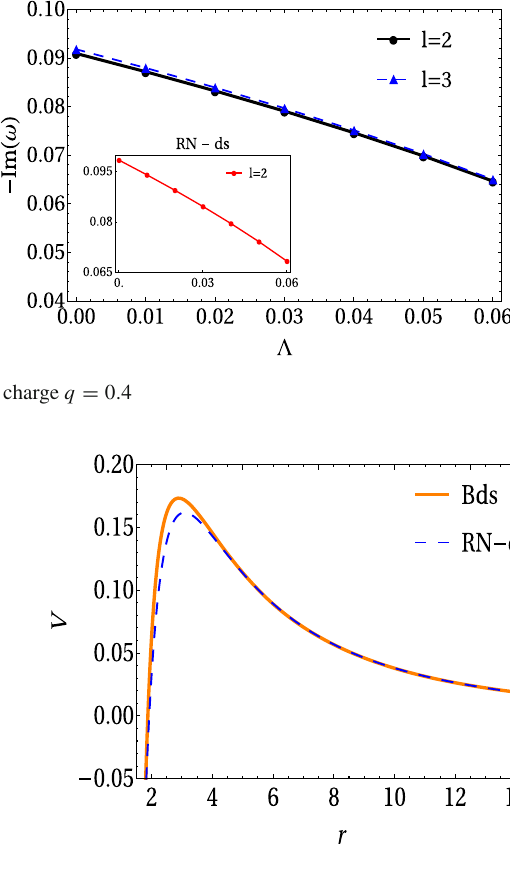
Fig. 6 Variation of gravitational potential V in Regge–Wheeler gauge with r for (cid:12) = 2, (cid:2) = 0 . 003 and q = 0 . 40